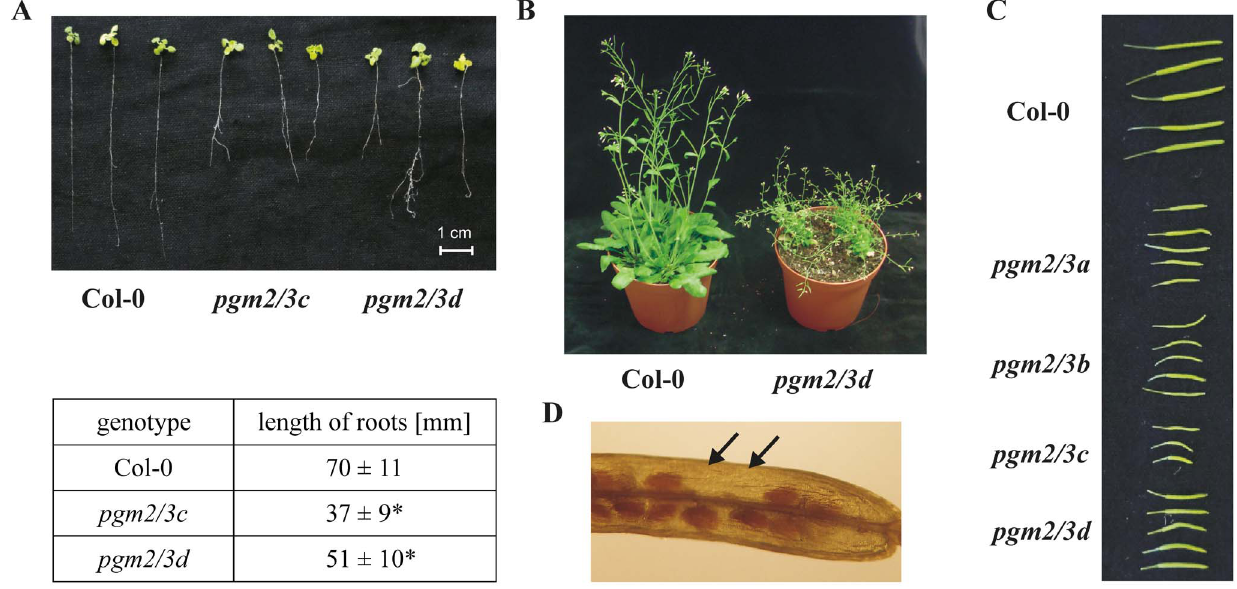
Figure 4. Roots and siliques of Col-0 and pgm2/3 plants. A, Root length and morphology of Col-0 and pgm2/3 lines. Plants were grown on vertical MS plates without any external sugar and antibiotics under long day conditions (16 h light/8 h dark). Plants were two-week-old. Length of central roots was measured. Values are means 6 SD (n=26 2 35). Asterisks indicate significant difference from Col-0 (Student Test, P # 0.01) B, Mature Col-0 and pgm2/3d plants. Col-0 and pgm2/3 plants were six and 11- week-old, respectively. C, Morphology of siliques of Col-0 and pgm2/3 lines. D, pgm2/3d silique. Siliques were destained in chloral hydrate solution (2.5 g in 1 mL distilled water). Black arrows indicate absence of seeds. C–D, Plants were grown under 14 h light/10 h dark regime.